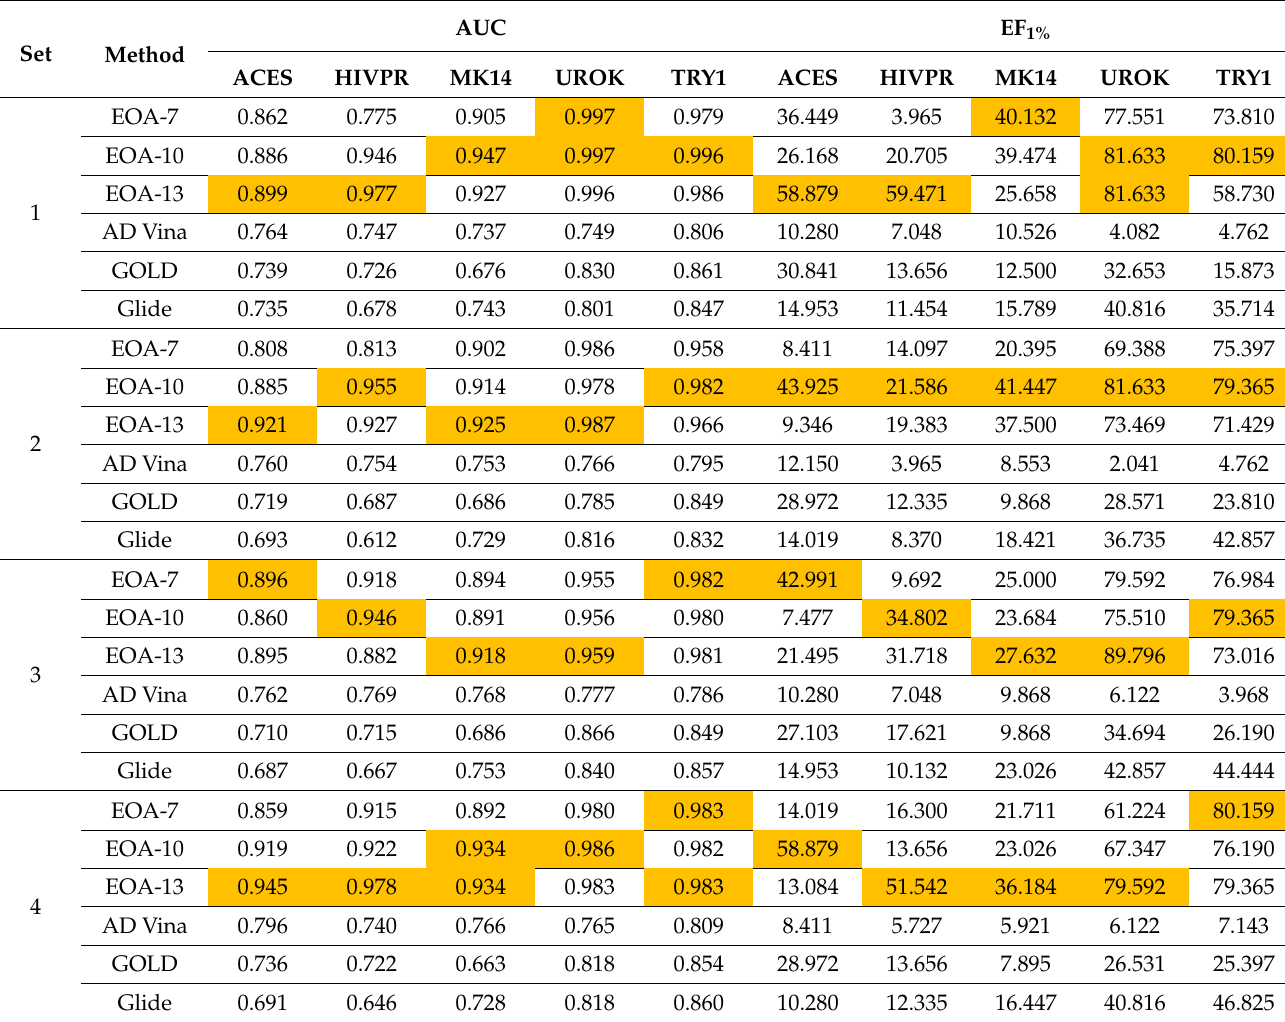
Table 2. EOA and docking results for all test sets expressed in terms of AUC and EF 1% values. The docking results are presented as consensuses of two crystal structures per target. For each dataset, the best result is highlighted. We note that EF 1% values are indifferent to the order of the active compounds within the first 1% of the library, and it was therefore not unlikely to obtain identical EF 1% values from different